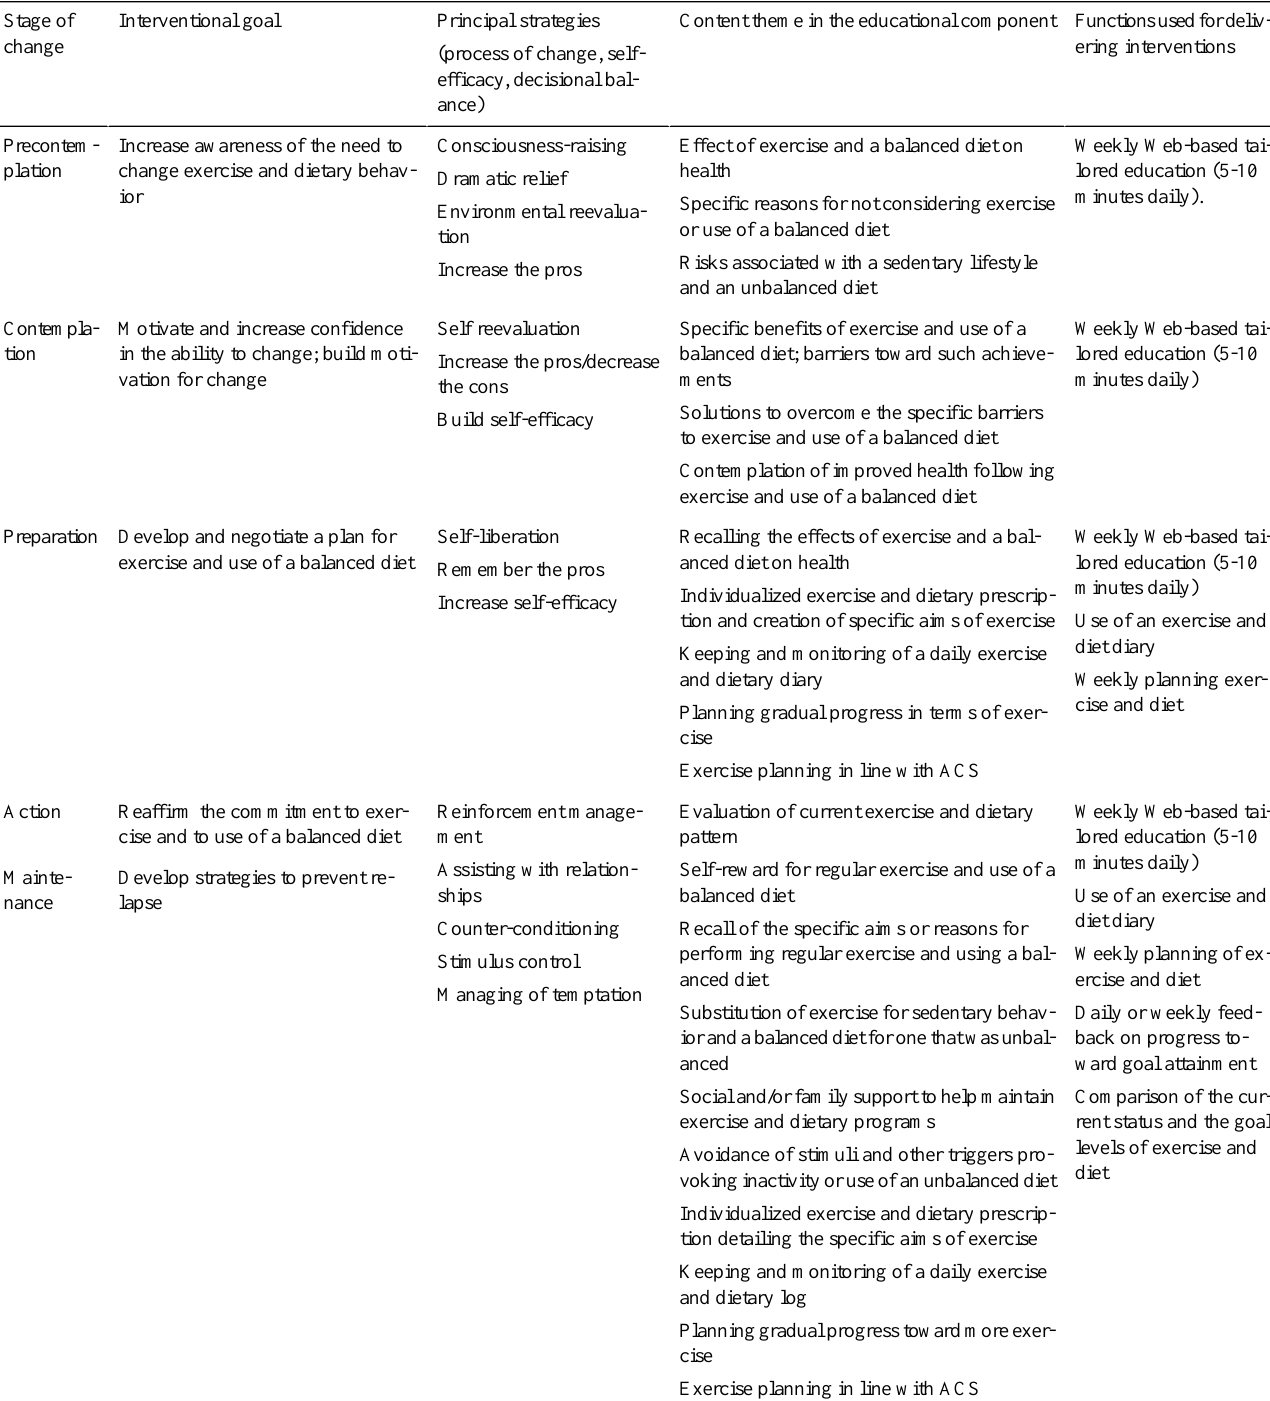
Table 1. Protocol of the Web-based self-management exercise and diet intervention program.